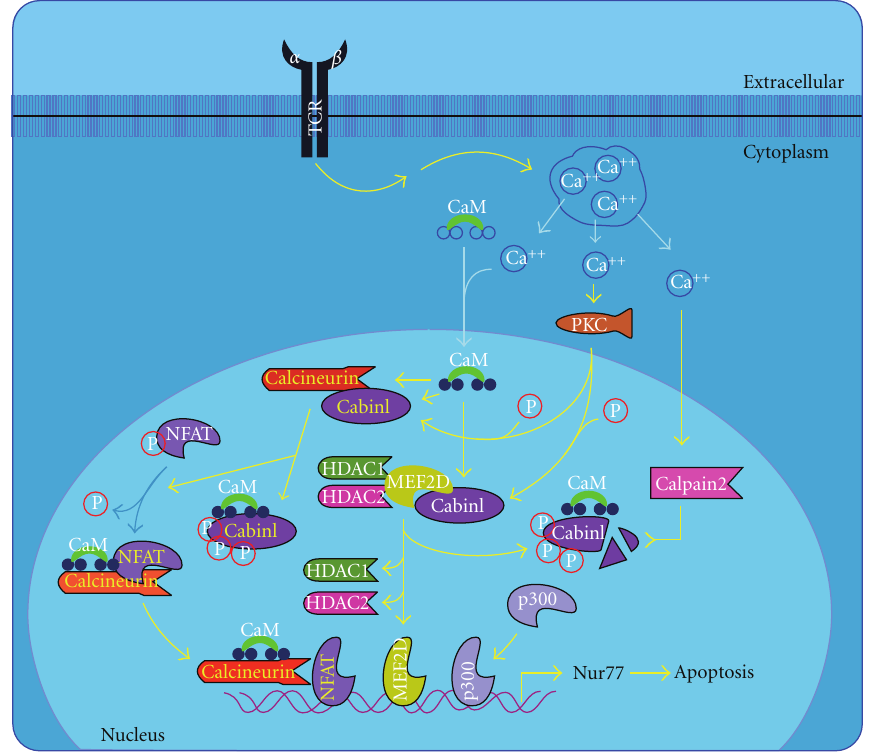
Figure 7: T cell apoptosis pathway extracted from BioCarta database